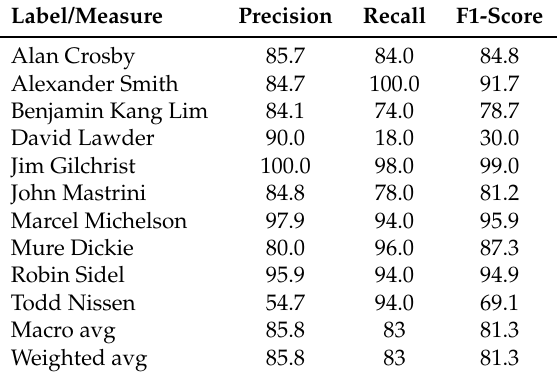
Table 3. Precision, recall and F1-score results for each class in turn for the CGR-DL on CCAT10. The last two rows show the macro and weighted